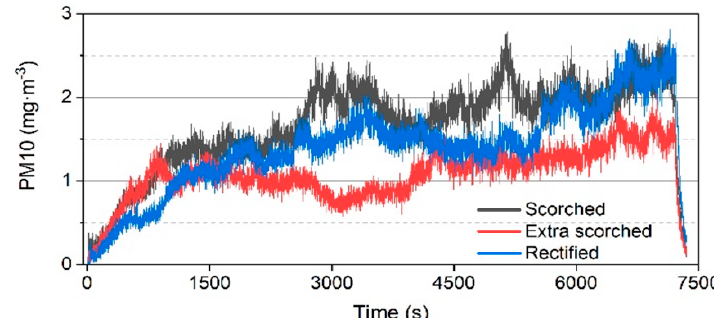
Figure 7. Representative measured PM10 curves for the three surface types.